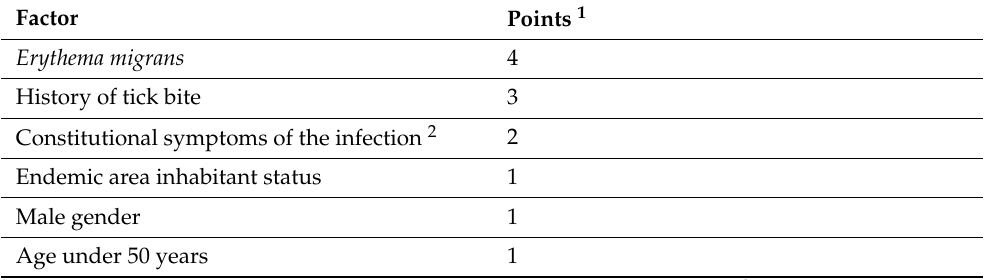
Table 4. Lyme carditis suspicion index